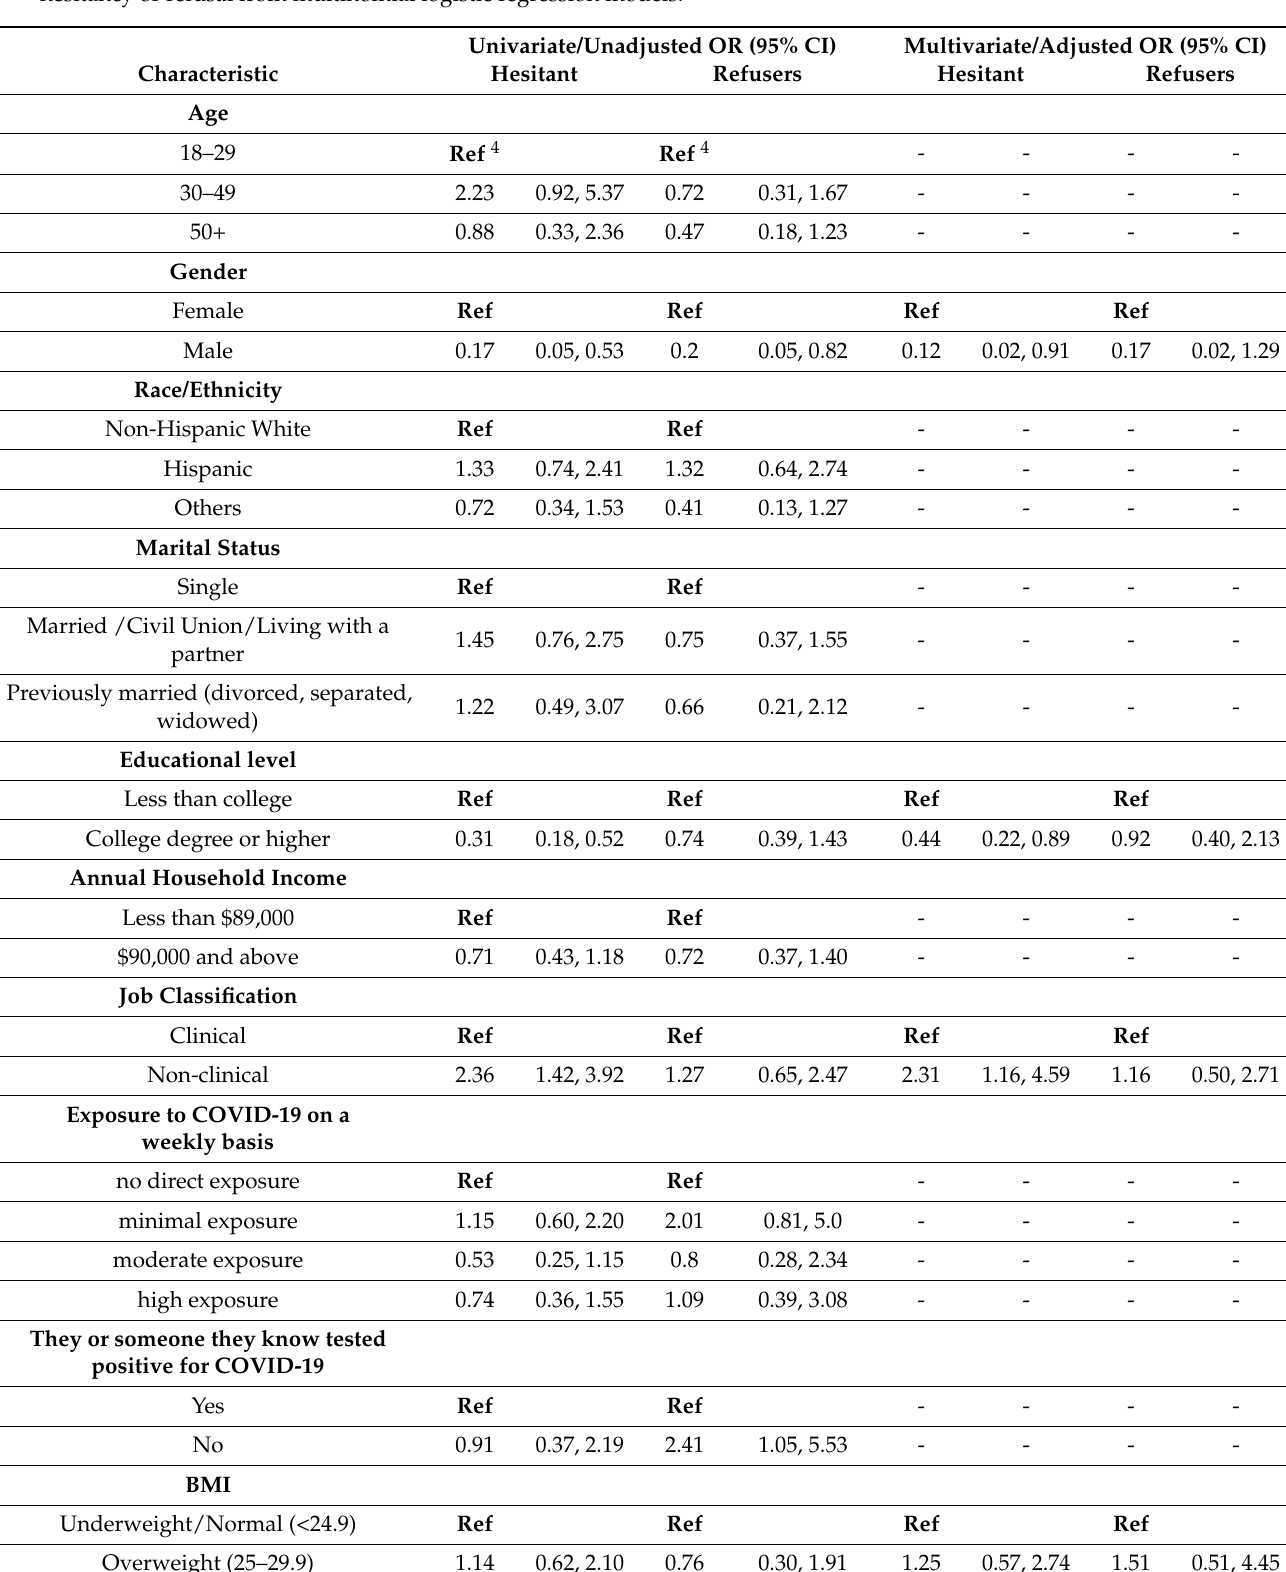
Table 3. Univariate and multivariate associations (ORs, 95% CIs) between potential predictors of the vaccine acceptance, hesitancy or refusal from multinomial logistic regression